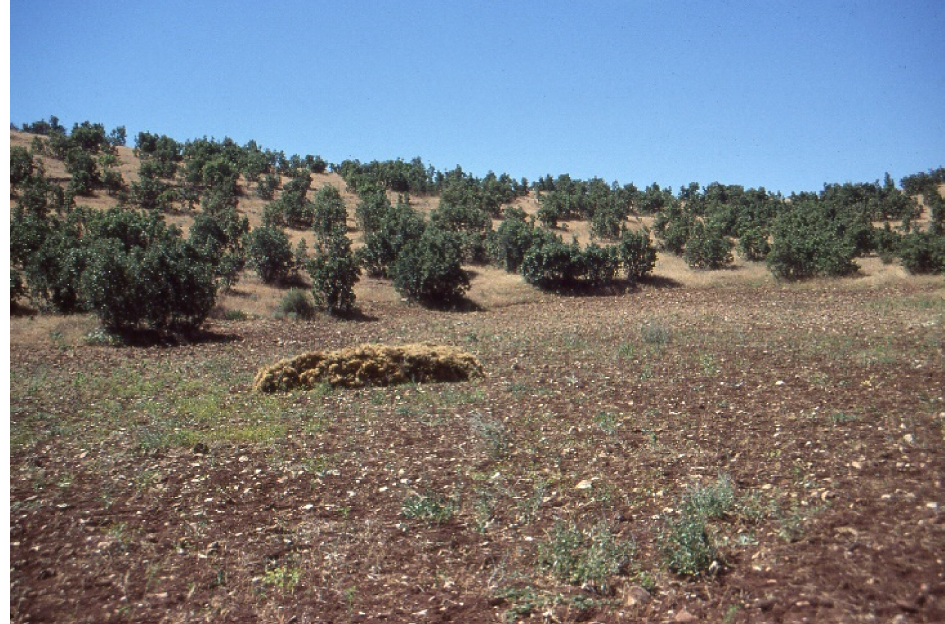
Figure 5. A lentil field after harvest by hand-pulling near Midyat, Mardin Province, southeast Turkey, June 2002. A range of weeds can be seen (some still green) while the mature lentil plants are piled and await transportation to the threshing grounds near the village (Photo by S. Abbo).